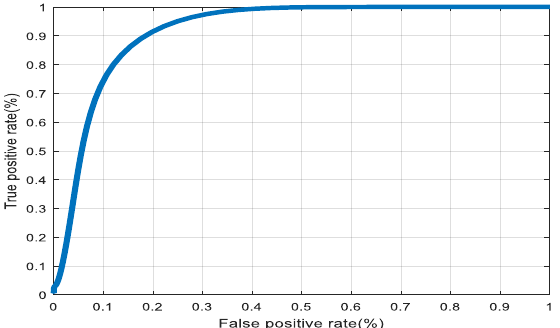
Figure 22. ROC curves for the system using an encrypted kernel with the circular encryption with a noise variance of 0.02.